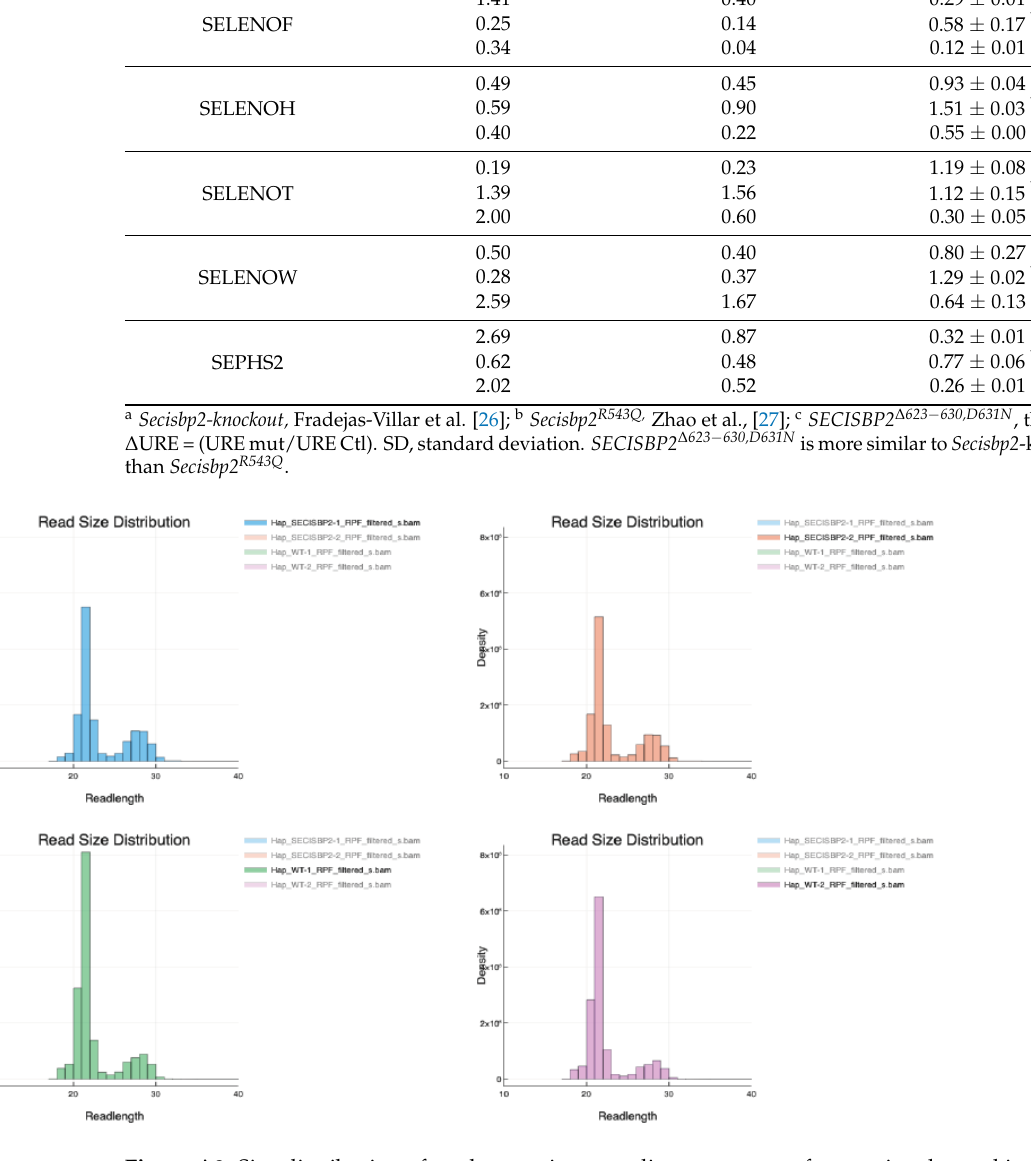
Figure A3. Size distribution of reads mapping to coding sequences of transcripts located in the cytoplasm and expressed in HAP1 cells. Reads around 21 nucleotides length represent “small” ribosomal footprints (sRPF, A-site not occupied) and reads of 28 nucleotides length represent “big” RPFs (A-site occupied). For pUGA and related measures, only reads of 20 + 21 and 28 + 29 nucleotides were selected, since in these RPFs, the first base of the P-site is 12 nucleotides from the 5 ′ end. These species are also the most abundant species in their respective peaks.